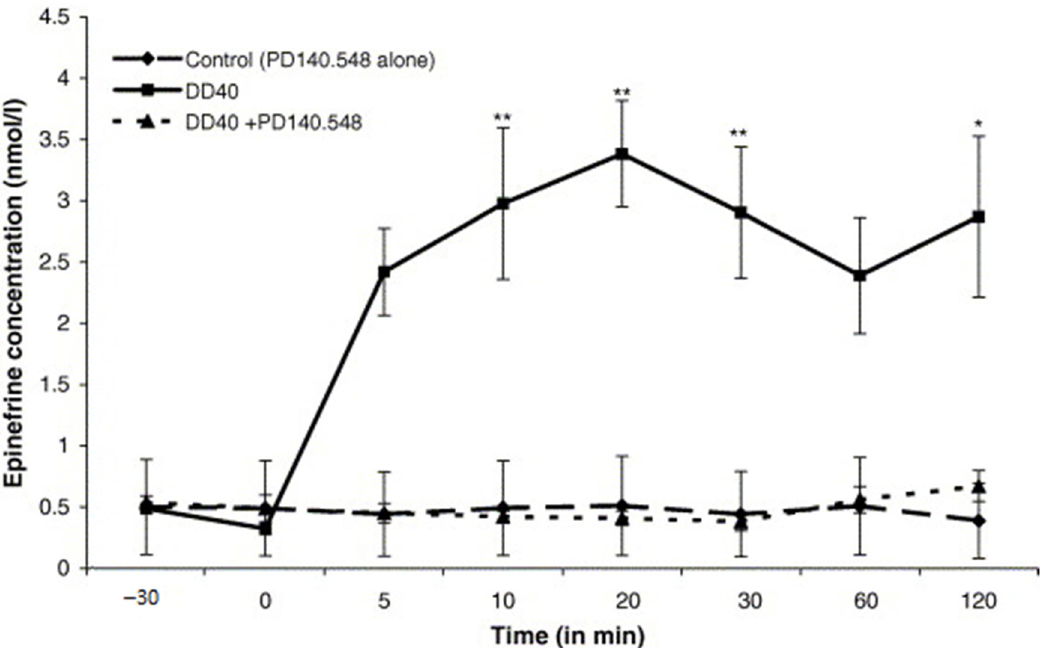
Figure 8. Comparative analysis of PD140.548 (ICV infusion) on changes in plasma epinephrine concentrations before and after 5 min of DD40 episode in comparison to controls (100 µL of 0.9% NaCl, n = 6 ± SEM). Points that are significantly different from control are marked with asterisks [50]; * p < 0.05 and ** p < 0.01.